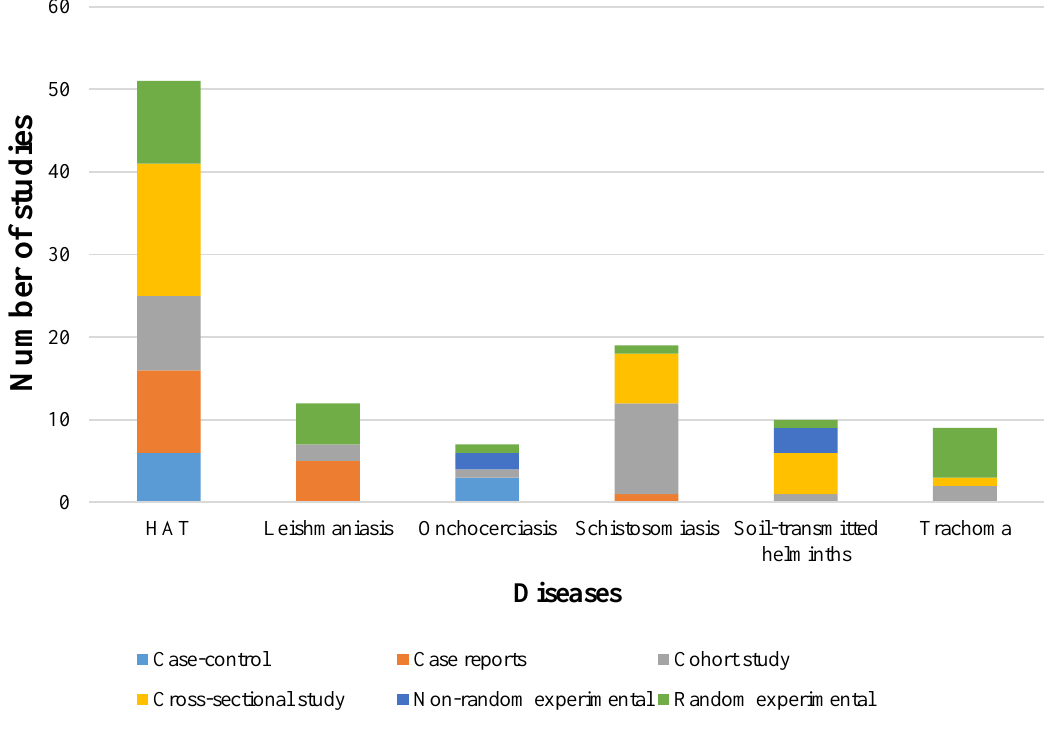
Figure 2. Prevalence of the study types of diseases. HAT: human African trypanosomiasis.